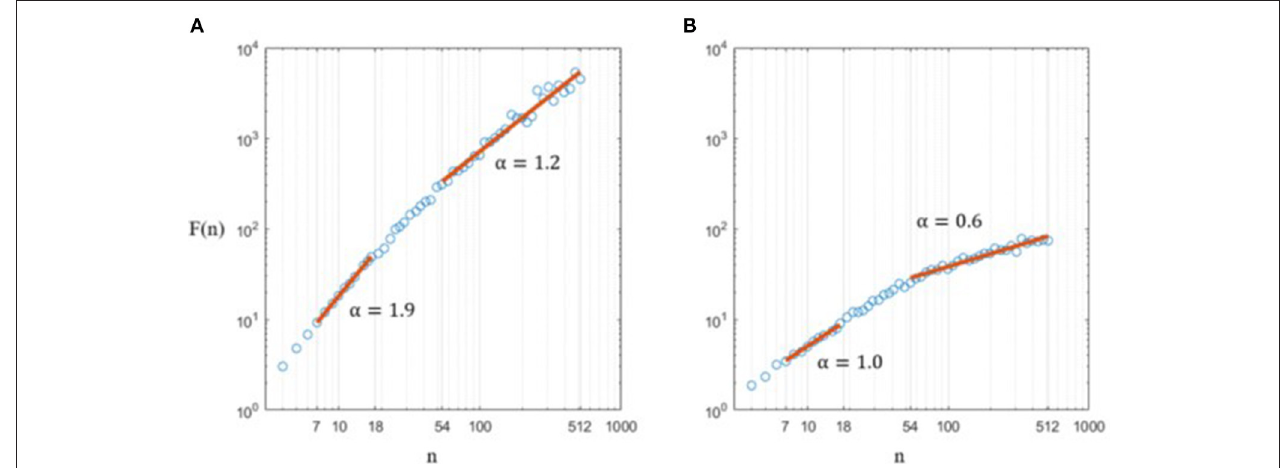
FIGURE 5 | Calculations of scaling exponents α on a typical CoP displacement along the AP axis (A) and of the same signal, derived (B) .